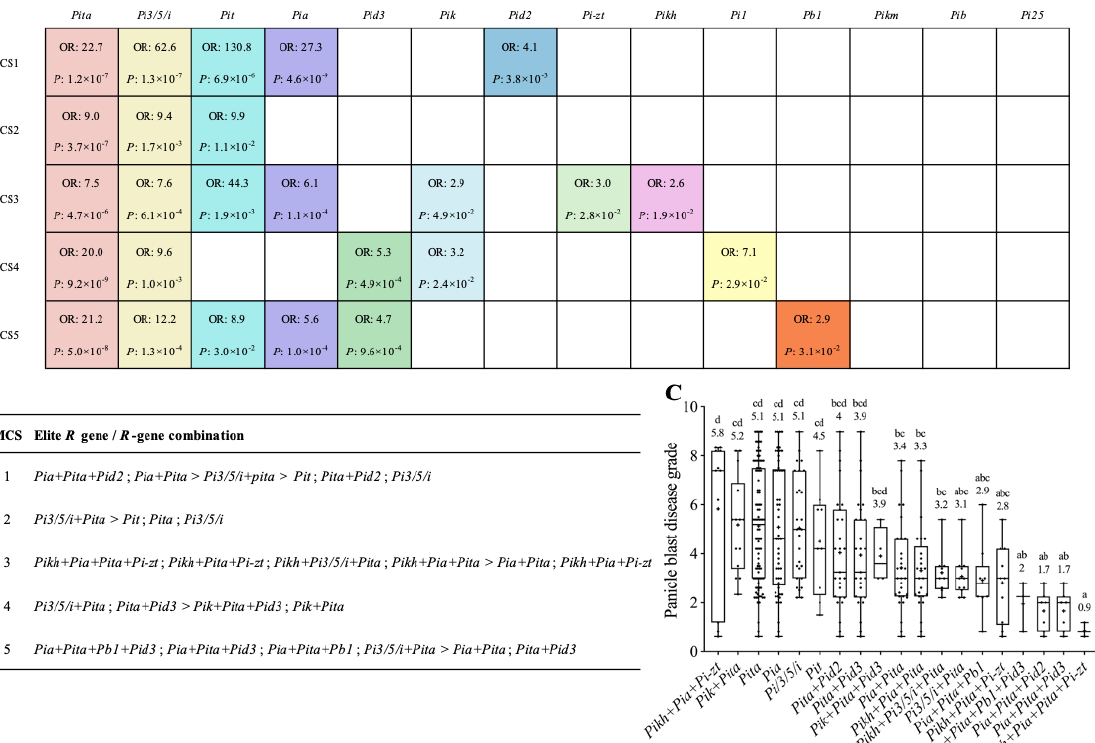
Figure 3. Analysis of elite R genes and R-gene combinations for panicle blast resistance. ( A ) Summary of the R genes that have significant contributions to panicle blast resistance in 5 MCS groups. OR represents the odds ratio. p -value compares varieties with and without the test R gene according to Duncan ’s multiple range tests. ( B ) Summary of the elite R genes/ R -gene combinations that have significant contributions to panicle blast resistance in each MCS inoculation. The panicle blast disease grades of those elite R genes/ R -gene combinations were significantly lower than their corresponding control in respective MCS; their disease grades are in ascending order from left to right. “>” indicates significant differences according to Duncan’s multiple range tests. ( C ) Comparison of the panicle blast disease grades of different elite R -gene combinations. The numbers indicate the average disease grades. Different lowercase letters denote significant differences according to Duncan ’s multiple range tests ( p < 0.05).